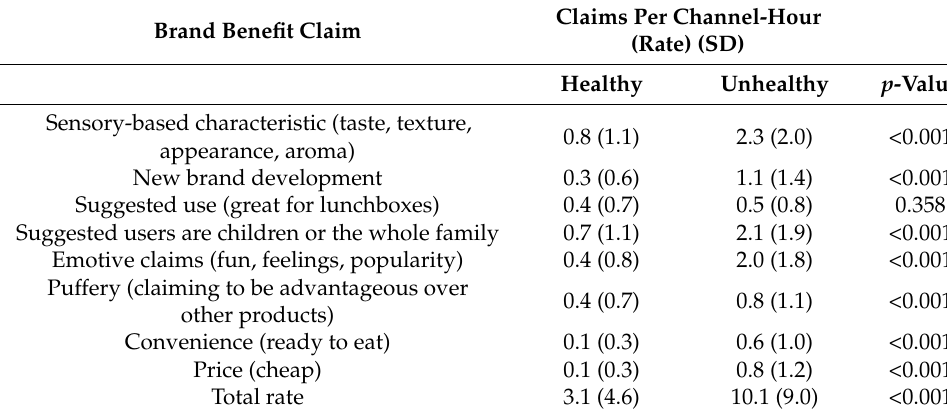
Table 4. Mean rates of use of brand benefit claims.